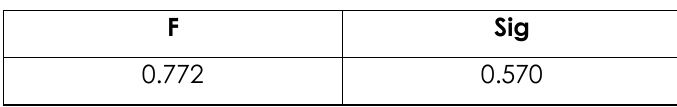
Table 8. ANOVA Table of Hypothesis